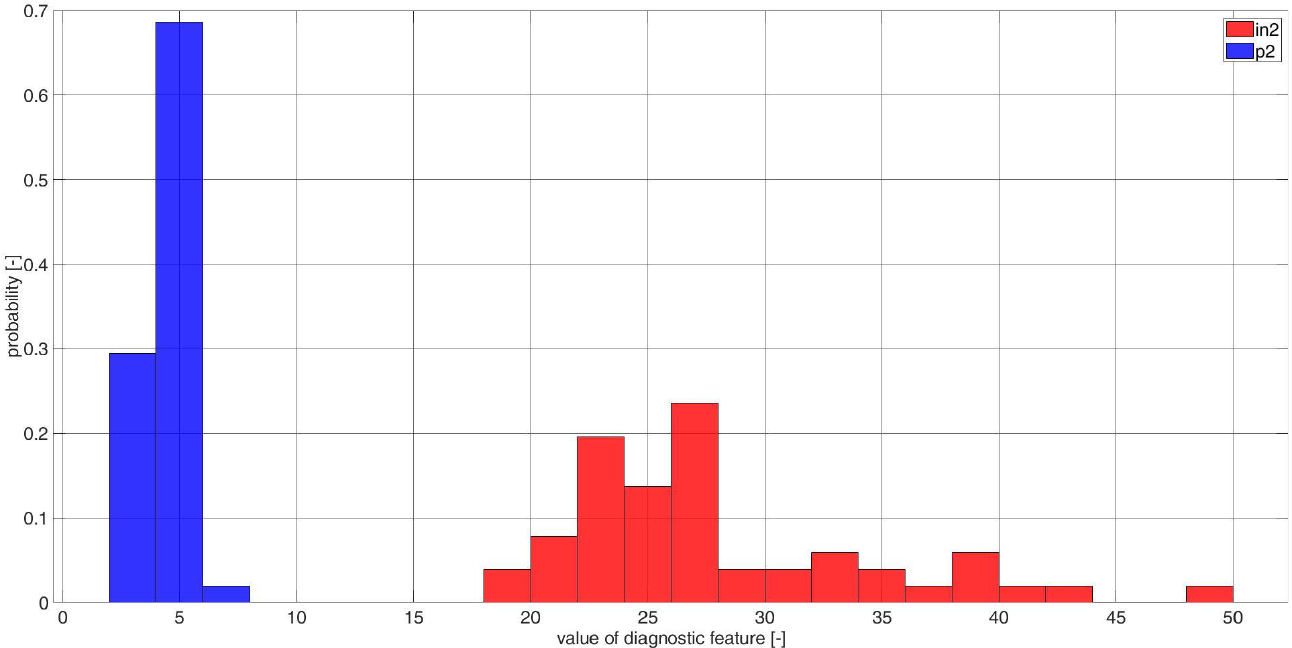
Figure A17. Histograms of diagnostic features based on the CCSM3 (correlation number is 20— Table A1) bearings in1 and p1. Table A1) bearings in1 and p1.